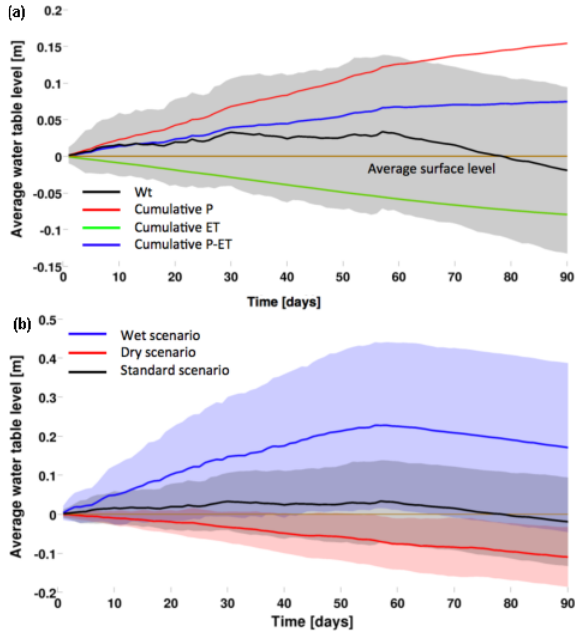
Fig. 6. Ensemble averages of 30 model simulations in different sce- narios. Panel (a) displays seasonal variations of area covered by saturated centers in a wet (blue line), dry (red line), and standard (black line) scenario. Saturated centers represent the major contri- bution to methane emission in this area, and in our model their total area drops in both dry and wet scenarios. Panel (b) shows modeled total methane emissions from the whole landscape in the three sce- narios. Despite a decrease in the number of high-emissive saturated centers, our simple model shows increased methane emission in the wet scenario because of a drop in the area covered by the relatively drier tundra (moist centers and elevated